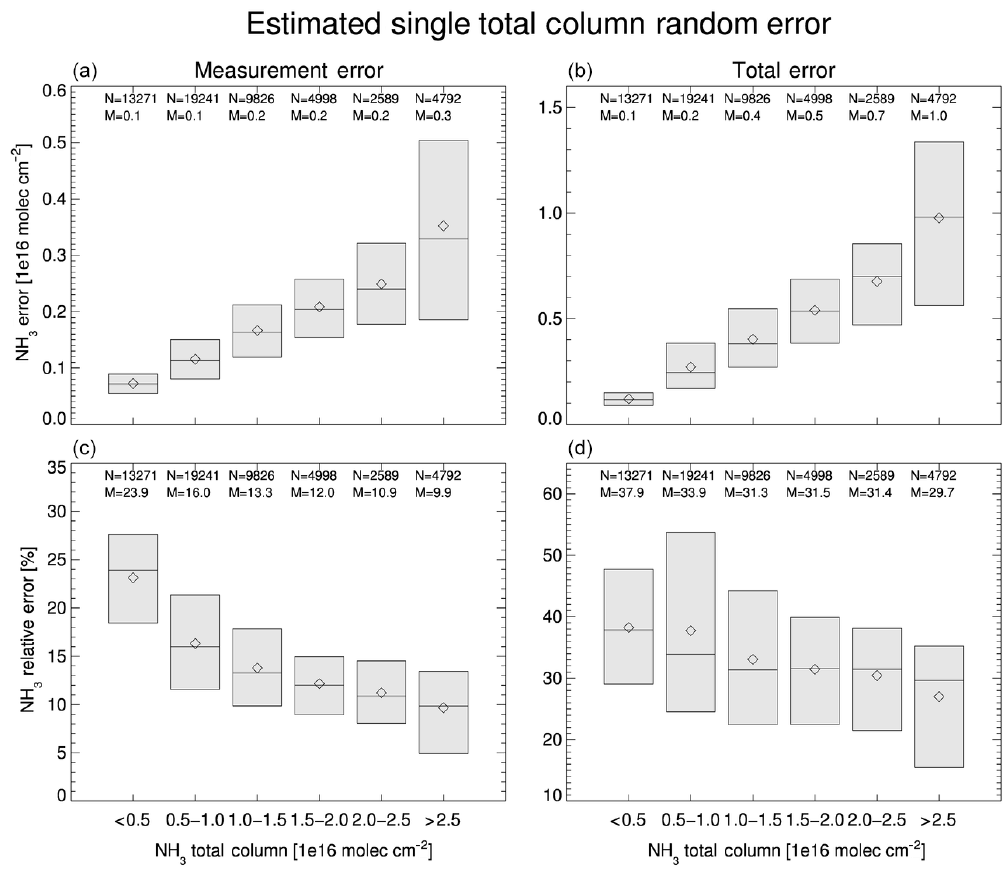
Figure 3. Estimated CrIS-retrieved NH 3 total column measurement and total error statistics from global values for 28 May 2017. Both absolute error estimates (a, b) and corresponding relative (fractional) errors (c, d) are shown. The diamonds are the mean values for each box range. Only retrievals over land with a quality flag of 5 (therefore DOFS ≥ 0 . 1) were included. The N and M are the number of points and the median value for each box,